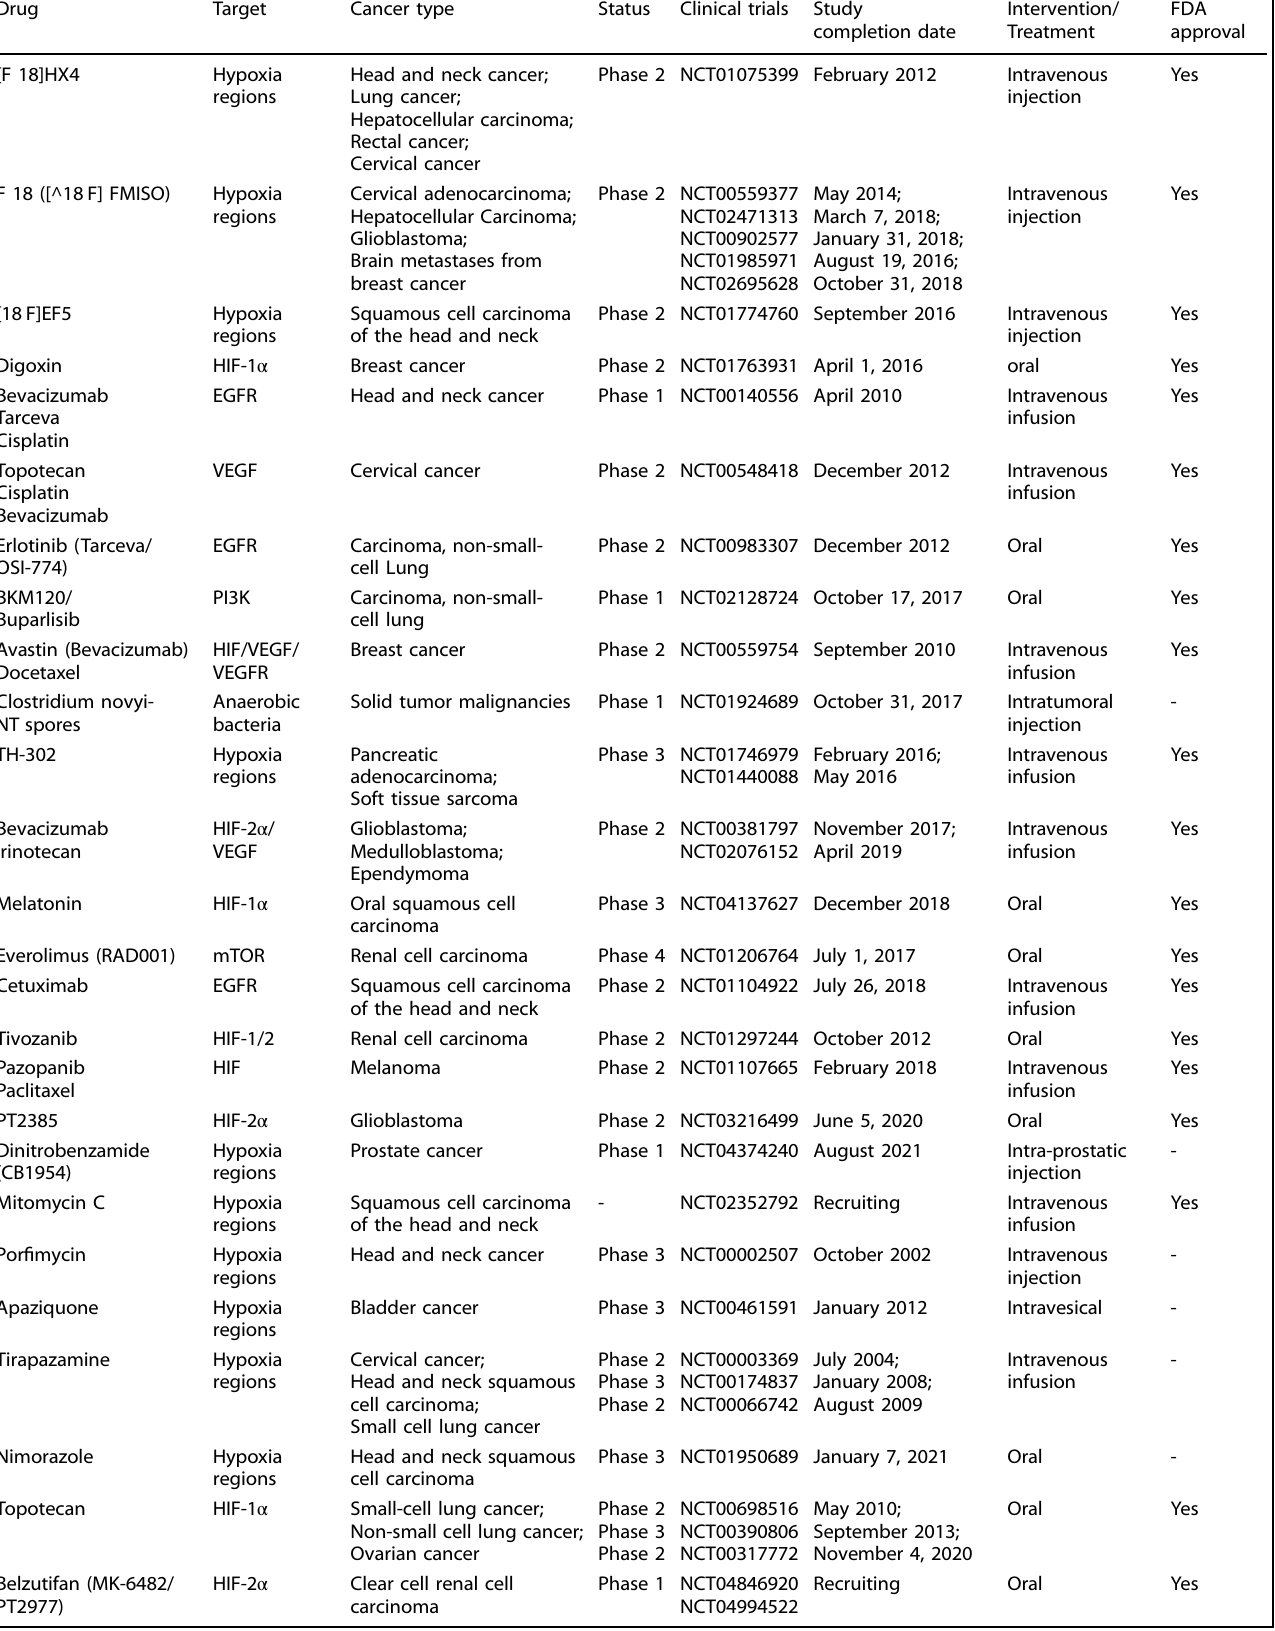
Table 2. Clinical trials targeting hypoxia in tumors